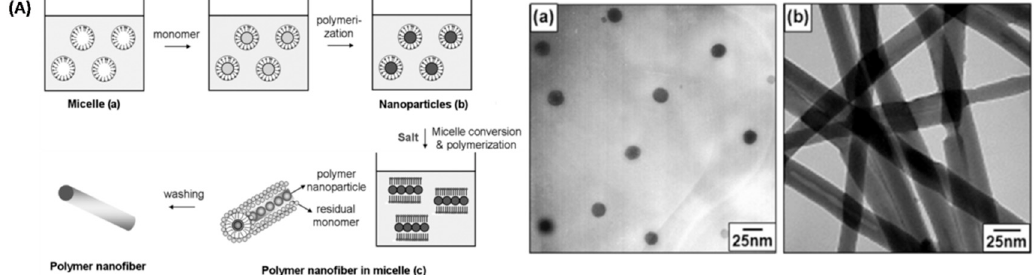
Figure 10. ( A ) Synthetic procedure of PAN-NFs using microemulsion polymerization TEM images of ( a ) PAN-NPs with an average diameter of 20 nm and ( b ) PAN-NFs with an average diameter of 25 nm with 0.3 M DoTAB.